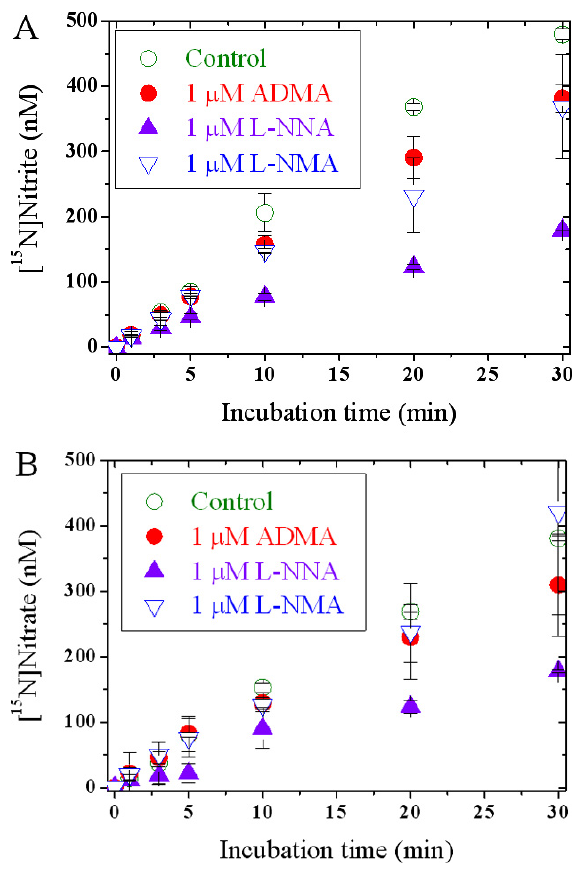
Figure 1. Time dependency of the inhibition of eNOS activity by various guanidino – substituted L – arginine analogs. eNOS- dependent (45 μ g/ml) formation of 15 NO 2 – (A) and 15 NO 3 – (B) from L – [ guanidino – 15 N 2 ]arginine (20 μ M) in the absence of any inhibitor and in the presence of ADMA, L-NNA, or L-NMA (each at 1 μ M). Values are shown as mean ± SD from duplicate